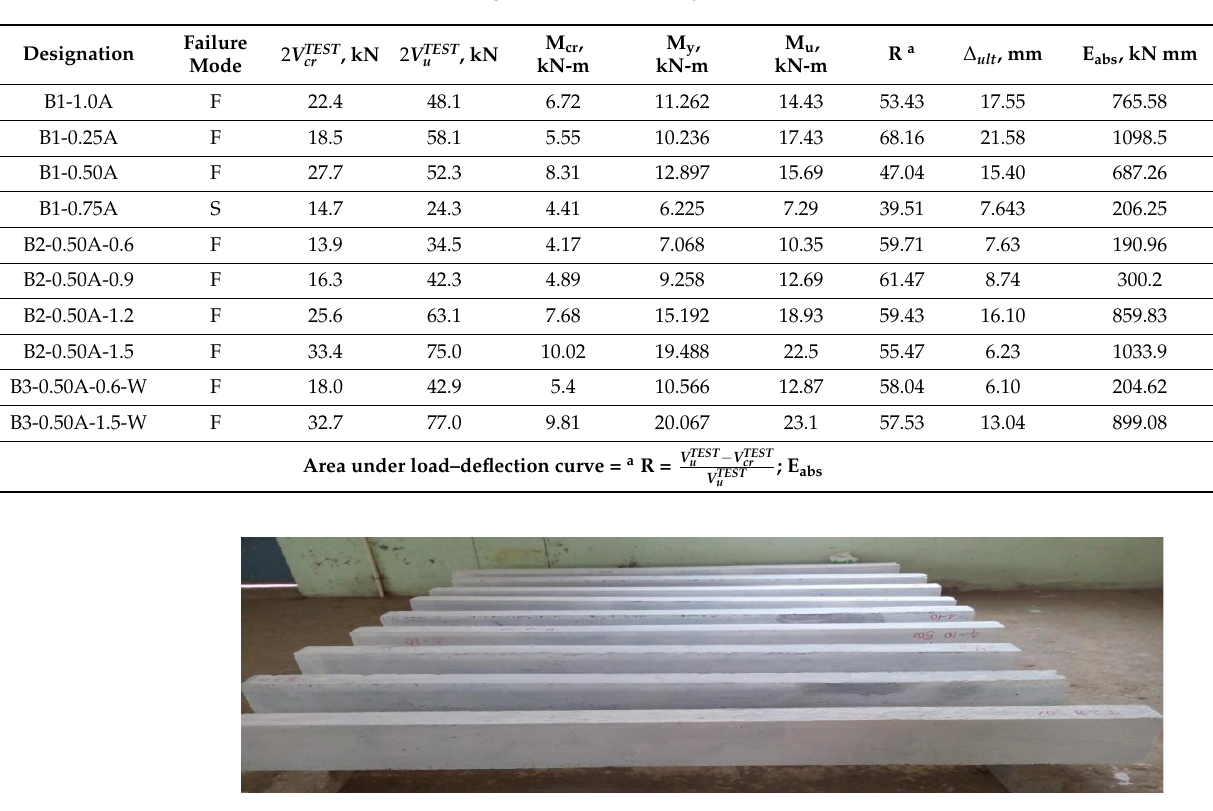
Table 3. Mechanical Strength and serviceability results.